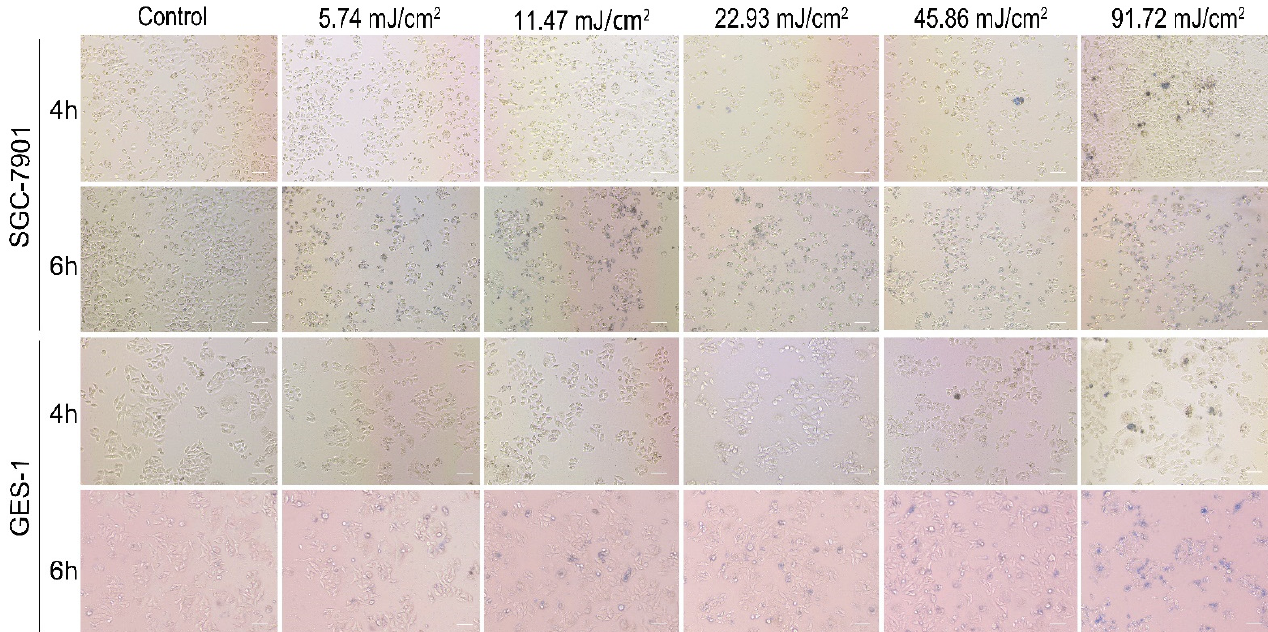
Figure 4. The Trypan blue staining of SGC-7901 cells and GES-1 cells after treated with PEG-AuS irradiated with different irradiation dose.